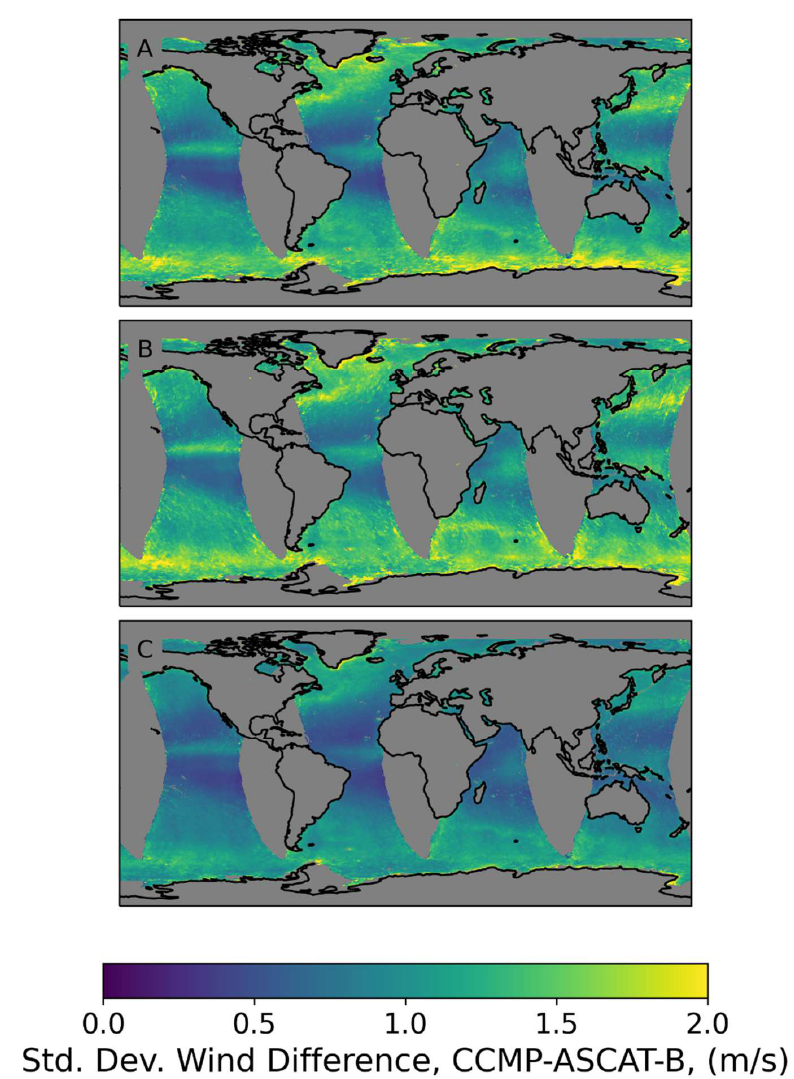
Figure 12. Maps ( A ), Zonal Wind; ( B ), Meridional Wind; ( C ), Wind Speed of standard deviation of the difference between CCMP ERA5 ADJ. vs. ASCAT-B, averaged over the 2013–2019 period. As was the case for Figure 11 these maps were made using all rain-free collocations and are intended to serve as an estimate of the performance of the CCMP ERA5 ADJ wind product.